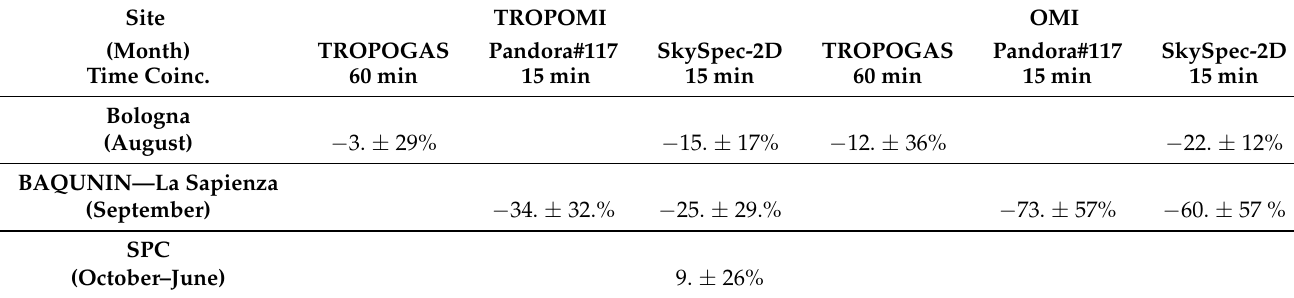
Figure 5. ( a ) NO 2 VCDs from TROPOGAS (in blue) and SkySpec-2D (in red), averaged in 5 min intervals, during the Bologna inter-comparison campaign. ( b ) Zoom onto days 5 and 6 August 2021. Table 2. Relative bias and spread in NO 2 total VCDs retrieved from satellites versus ground-based instruments for different locations. The radius used for spatial coincidence is 5 km around the station for TROPOMI and 20 km for OMI, while the time interval is 15 or 60 min depending on